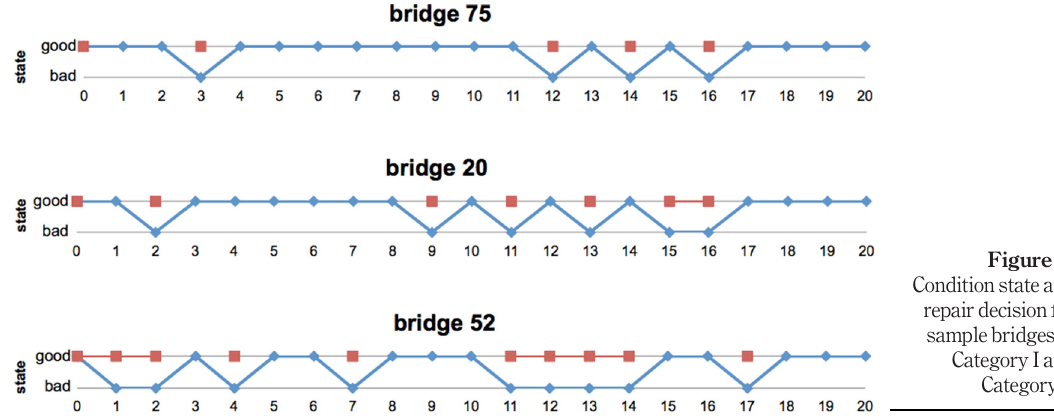
Figure 1. Condition state